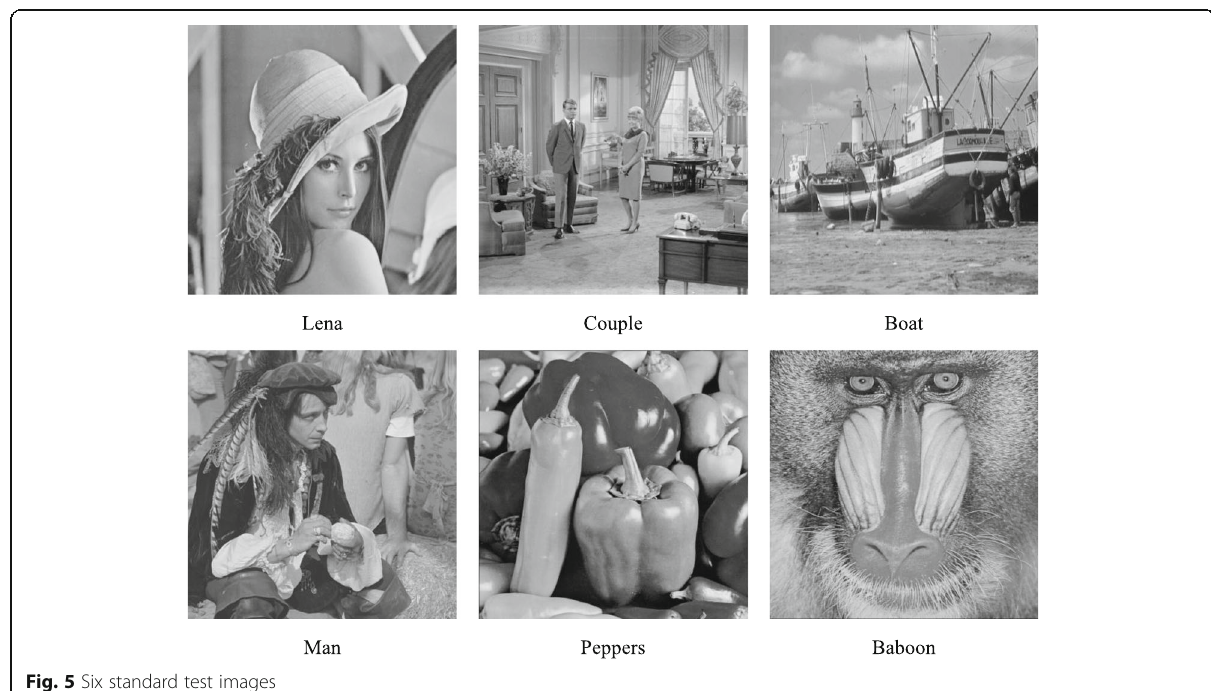
Fig. 5 Six standard test images